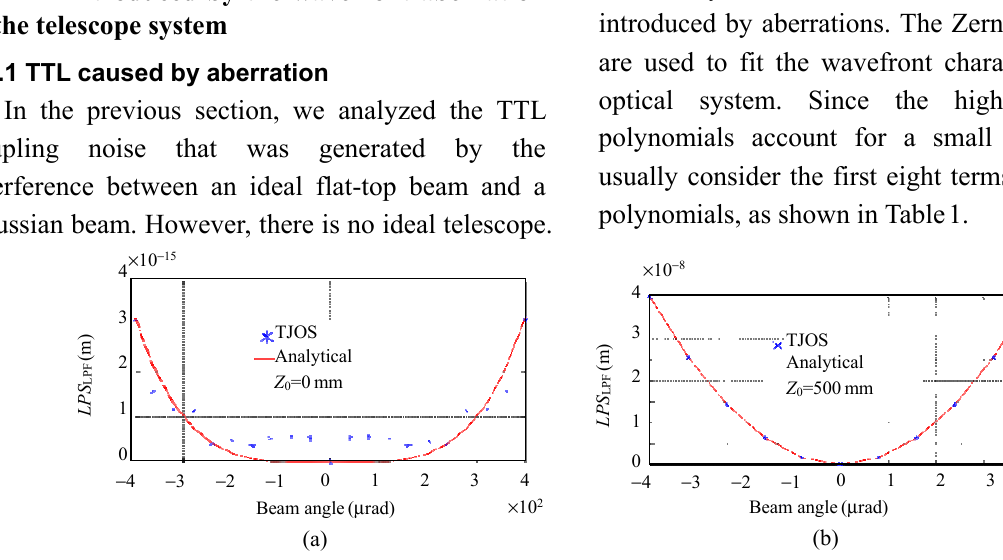
Fig. 3 Change in LPS with respect to the angle α : (a) shows that when the waist position of Gaussian beam coincides with LPF the rotation point of the flat-top beam, LPS is significantly below the picometer scale (the differences are numerical errors due to LPF ray tracing algorithm) and (b) shows that when the waist position of the Gaussian beam concides with the position of detector, LPS is equal to the optical pathlength difference. LPF Table 1 Zernike polynomials. Term Polar coordinates Cartesian coordinates Corresponding